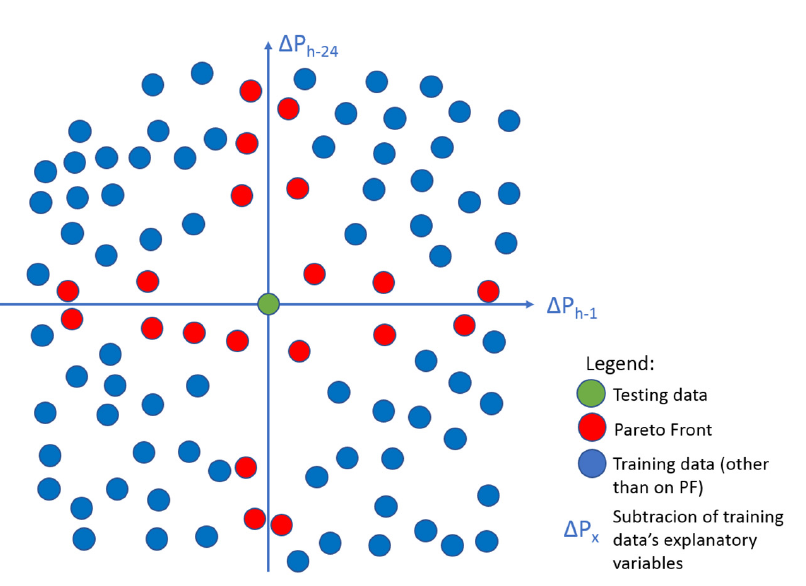
Figure 5. The example of testing data belonging to the first Pareto front in all four quadrants.